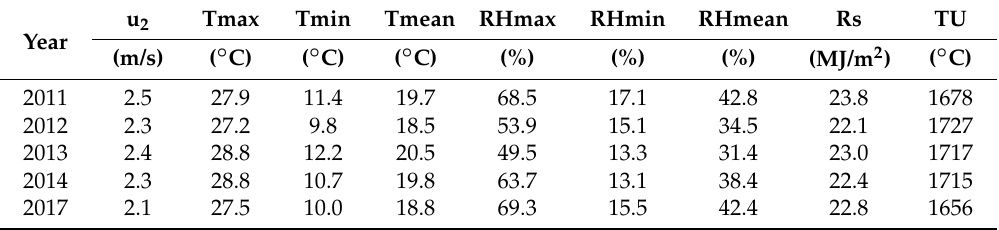
Table 1. Average climatic conditions during the five maize growing seasons, Farmington, New Mexico. u 2 : wind speed; Tmax: maximum temperature; Tmin: minimum temperature; RHmax: maximum relative humidity; RHmin: minimum relative humidity; Rs: solar radiation; TU: thermal